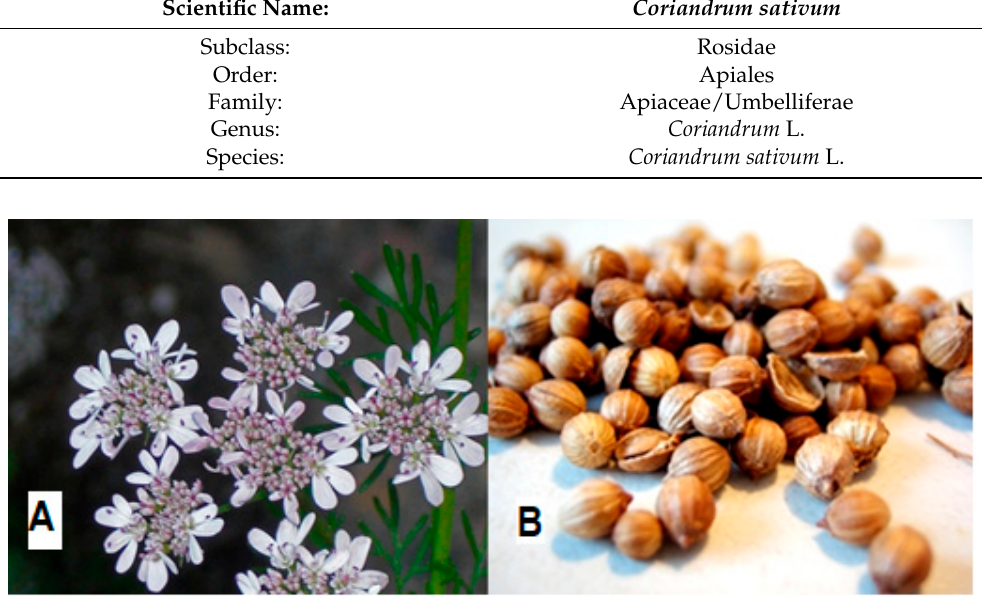
Figure 1. ( A ) C. sativum flowers (by Andrey Zharkikh). ( B ) C. sativum half and whole seeds (by ZoyaChubby). From North Carolina Extension Gardner: Plant toolbox. (https://plants.ces.ncsu.edu/ plants/coriandrum-sativum/, accessed on 20 December 2021).